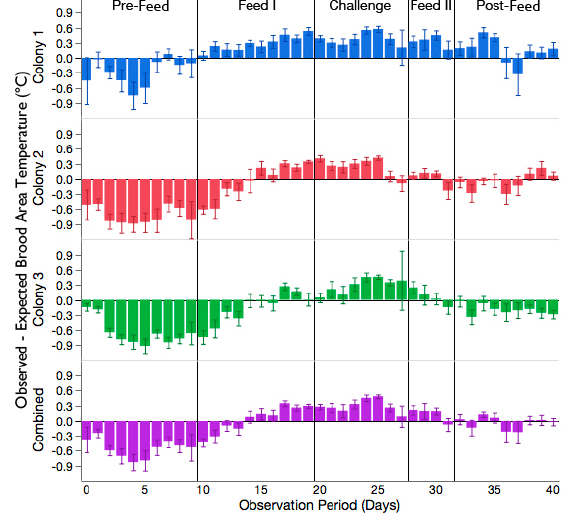
Figure 3. The daily di ff erence in observed–expected temperature of the brood area for each colony and the average of the three colonies combined. A value less than 0 demonstrates that the observed temperature of the brood area was less than the expected temperature and a value greater than 0 demonstrates that the observed temperature of the brood area was greater than the expected temperature. Vertical lines mark the boundaries between the observation periods. Each bar represents the mean daily di ff erence ± 95%